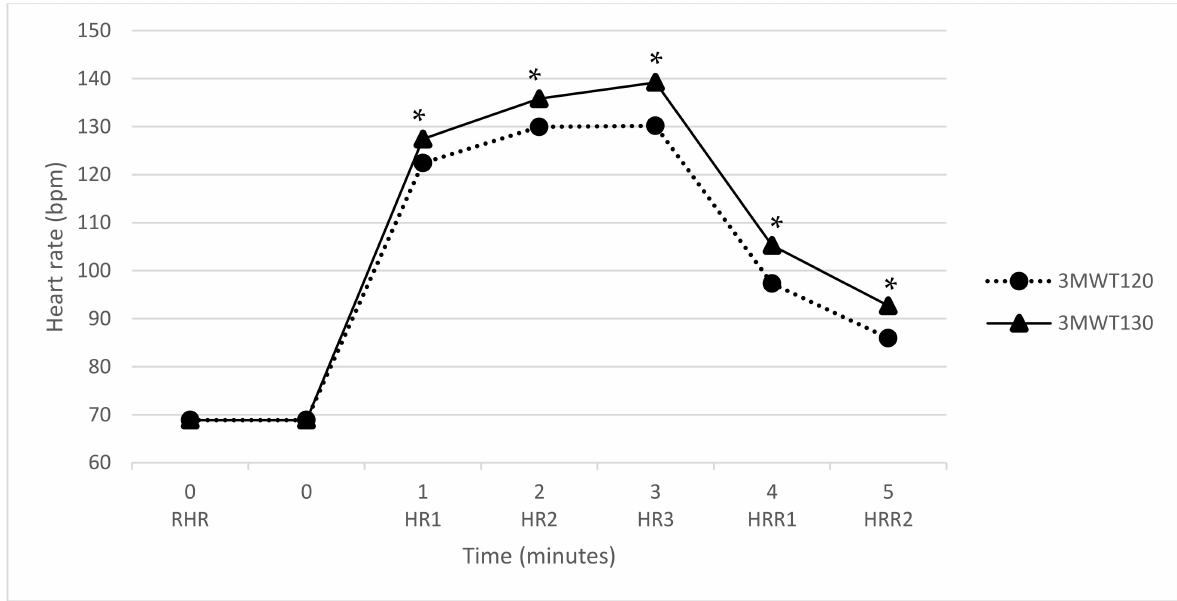
Figure 1. Heart rate response during the 3MWT at a cadence of 120 spm and 130 spm; * significant difference of p < 0.05. Abbreviation: 3MWT 120 , 3 min walk test at a cadence of 120 spm; 3MWT 130 , 3 min walk test at a cadence of 130 spm; spm, steps per minute; RHR, resting heart rate; HR1, heart rate at 1 min of exercise; HR2, heart rate at 2 min of exercise; HR3, heart rate at 3 min of exercise; HRR1, heart rate recovery at 1 min; HRR2, heart rate recovery at 2